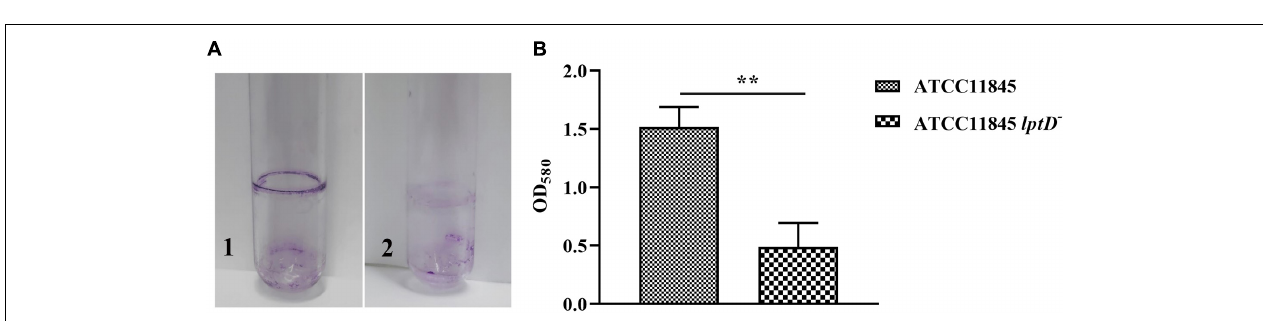
FIGURE 3 | Effect of low lptD expression on the growth of R. anatipestifer ATCC11845 in TSB. (A) The transcription of RA0C_1120 , lptD and RA0C_1122 in strain ATCC11845 and ATCC11845 lptD − . qRT-PCR analysis of the transcription of RA0C_1120 , lptD and RA0C_1122 in ATCC11845 and ATCC11845 lptD − in TSB. The data were analyzed using a t -test. The error bars represent the standard deviations of three independent experiments. (B) The growth of strain ATCC11845 and ATCC11845 lptD − in TSB. Cells were grown in 20 ml of TSB medium at 37 ◦ C with an initial OD 600 of 0.05. The OD 600 values were subsequently measured every 2 h for 16 h, ∗∗ , p < 0.01.